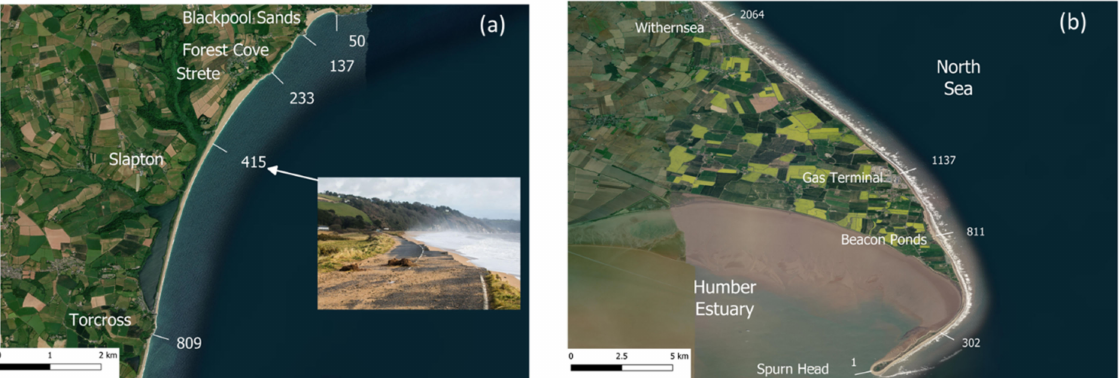
Figure 16. Location and ordinal of transects used in this study to indicate the main geographical features and used for the PCA interpretation; ( a ) Start Bay and ( b ) Spurn Head. Source of aerial imagery: Esri, Maxar, GeoEye, Earthstar Geographics, CNES/Airbus DS, USDA, USGS, AeroGRID, IGN, and the GIS User Community, v10.6. Source of damaged road image: Neil Shaw, 4 March